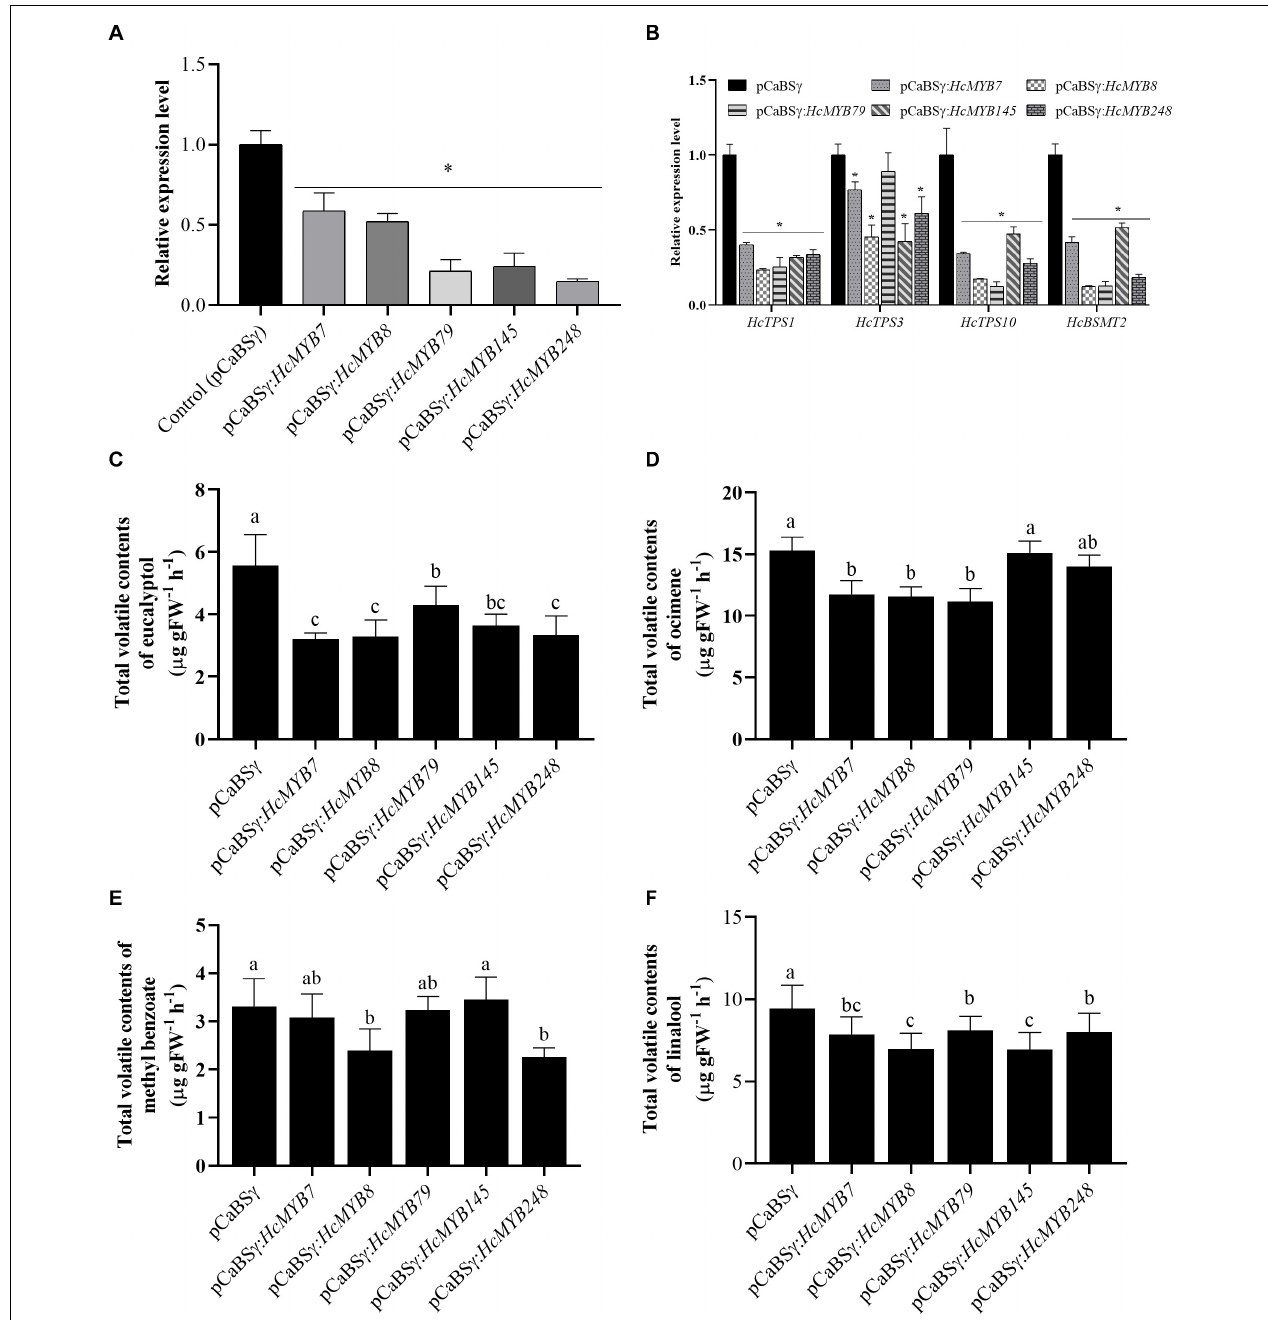
FIGURE 6 | HcMYB7/8/79/145/248 silencing changes the amount of main floral volatile contents and expression of key structure genes in H. coronarium flowers. (A) RT-qPCR analysis of HcMYB7/8/79/145/248 mRNA levels in BSMV silenced and control flowers. (B) mRNA levels of bottom structural volatile synthesis genes in BSMV silenced flowers compared with control. (C) GC-MS analysis of volatile contents of eucalyptol, (D) ocimene, (E) methyl benzoate, and (F) linalool after silencing of HcMYB7/8/79/145/248 genes. Data are presented as the mean ± SEM ( n = 3). Asterisk indicates significant differences [Student’s t -test, ∗ ( P ≤ 0.05)] between treatments and